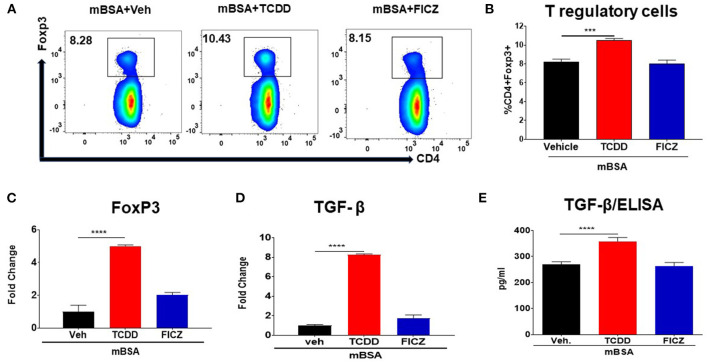
TCDD induces FoxP3+ Tregs during DTH response. DTH was induced as described in Figure 1 legend. Tregs, as well as expression of FoxP3 and TGF-β, were studied. (A) Representative plots from FlowJo software analysis of flow cytometry data showing CD4+ Foxp3+ cells from DLNs. (B) Percentage of CD4+Foxp3+ cells from groups of 5 mice. (C) qRT-PCR validation of mRNA expression of Foxp3 in DLN cells. (D) qRT-PCR based mRNA expression of TGF-β in DLN cells. (E) DLN cells were plated overnight in complete media and culture supernatants were harvested and subjected to ELISA for TGF-β. The statistically significant differences between the groups were calculated using one-way ANOVA. Vertical bars represent Mean ± SEM and significant differences between groups are shown with asterisks (***p < 0.001, ****p < 0.0001).